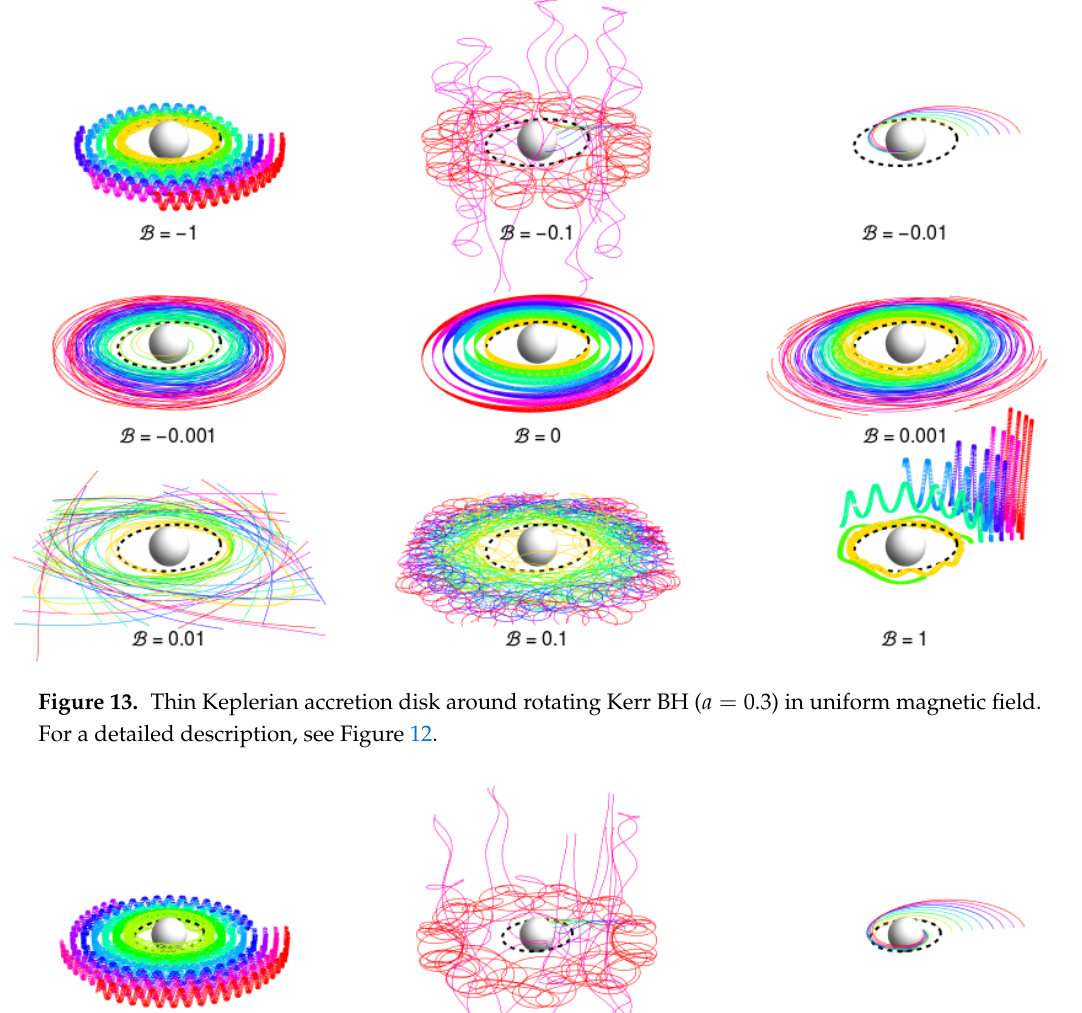
Figure 13. Thin Keplerian accretion disk around rotating Kerr BH ( a = 0.3) in uniform magnetic field. For a detailed description, see Figure 12.